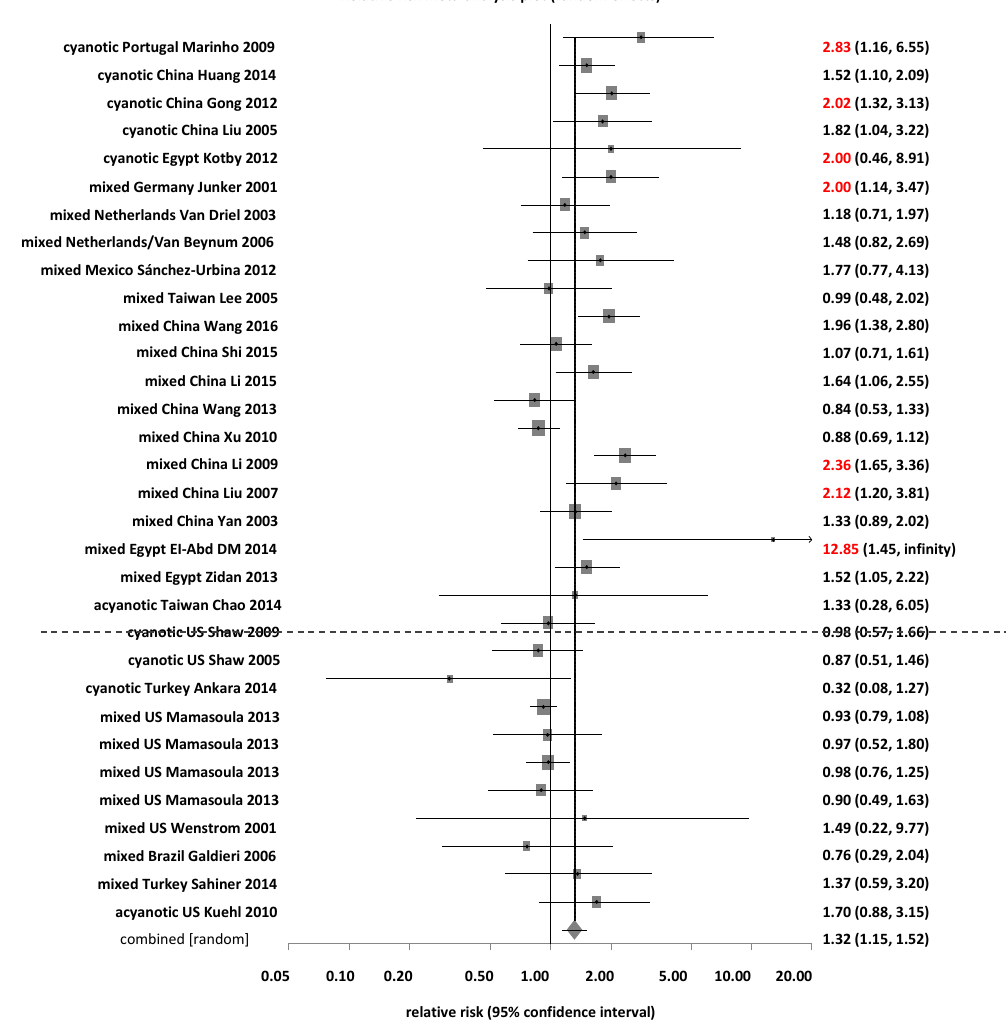
Figure 2. Forest plot of risks of congenital heart diseases (CHD) by MTHFR 677 TT polymorphisms per countries for children. Note. Cyanotic: cyanotic CHDs; mixed: cyanotic and acyanotic CHDs mixed; acyanotic: acyanotic CHDs; studies above dotted line: risk > 1; studies under dotted line: risk < 1; red words: risk > 2.